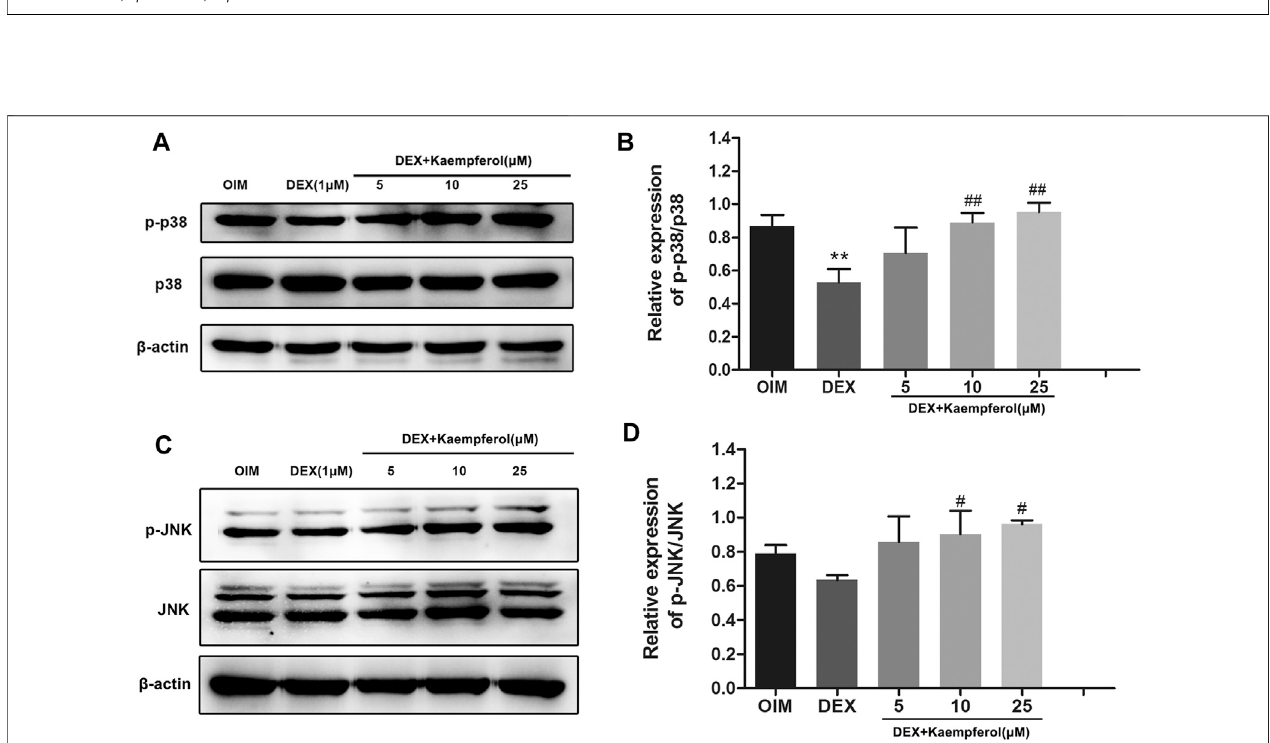
FIGURE8| Theeffectofkaempferolonthephosphorylatedproteinofp-p38andp-JNKinDEX-treatedMC3T3-E1cells.Thephosphorylationlevelsofp38 (A) and JNK (C) were detected by western blot. The quanti fi cation of p-p38/p38 (B) and p-JNK/JNK (D) was calculated. ** p < 0.01 vs. OIM; # p < 0.05, ## p < 0.01 vs. DEX.